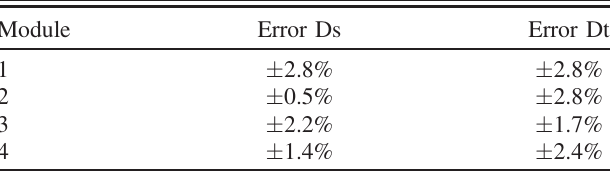
TABLE II. Errors of the Ds and Dt components of the single modules.